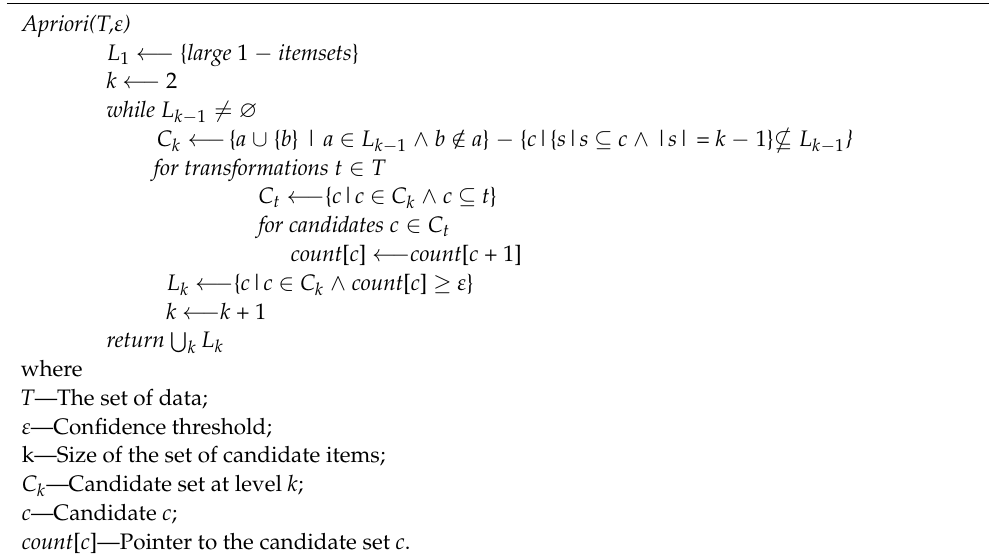
Algorithm 1. A Priori with breadth-first